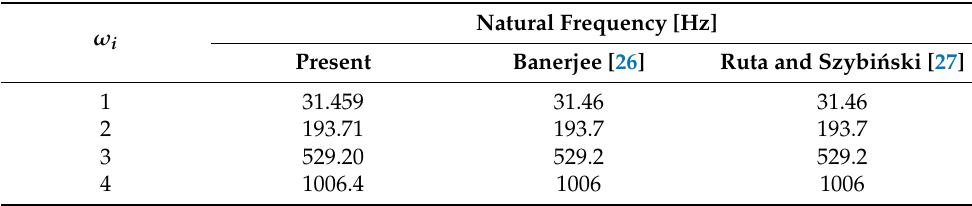
Table 1. Comparison of the results of previous studies and the present method for the first four natural frequencies of a symmetric three-layered beam with the cantilevered end condition. Natural Frequency [Hz] ω i Present